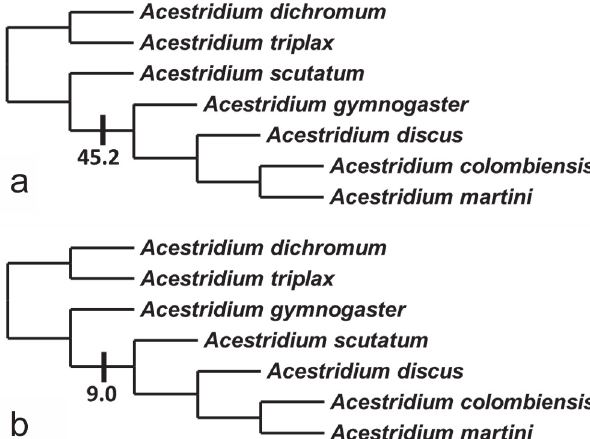
Fig. 10 . Two alternative primary trees depicting the phylogenetic relationships of the species of Acestridium